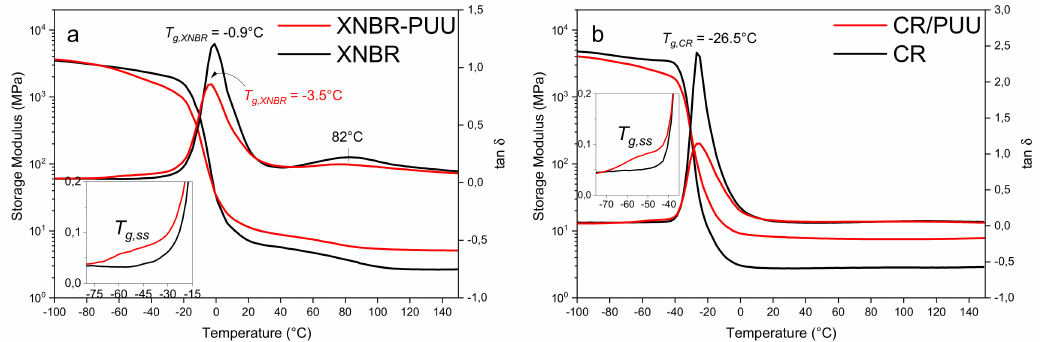
Figure 4. Storage modulus and tan δ as a function of temperature: ( a ) XNBR and XNBR/PUU; and ( b ) CR and